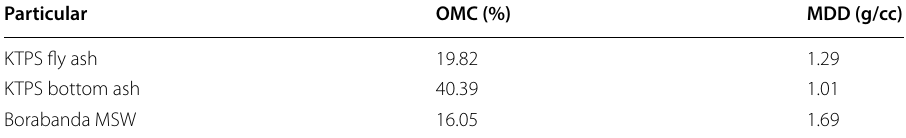
Table 2 Compaction characteristics of KTPS fly ash, KTPS bottom ash and Borabanda MSW Particular